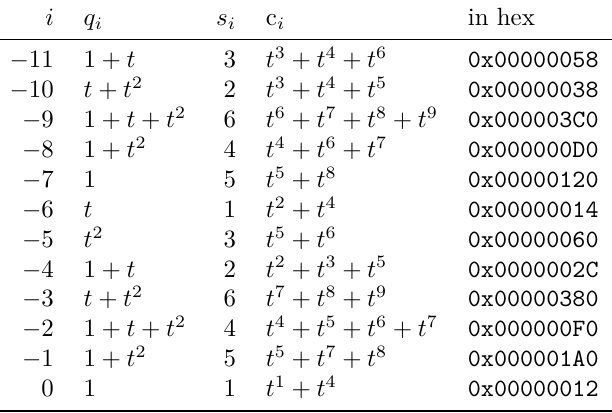
Table 10: The round constants with indices -11 to